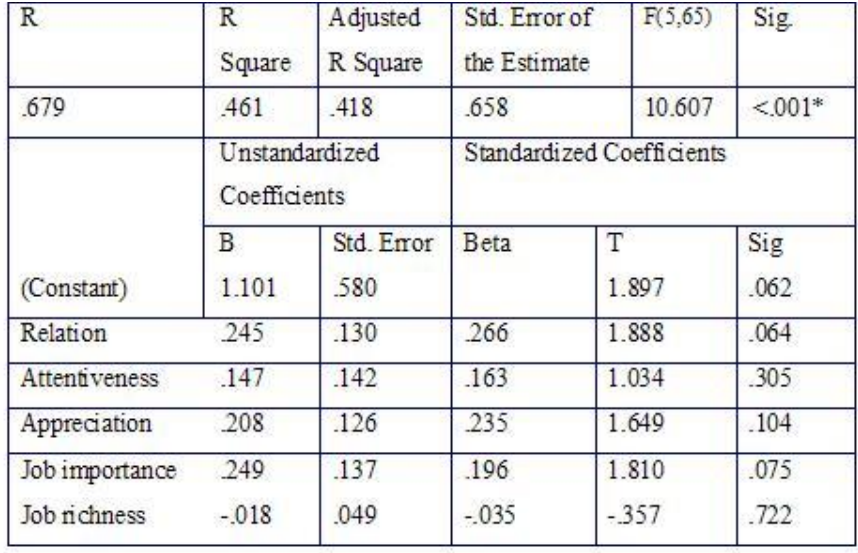
Table 3. A Univariate Regression Analysis for variables predicting "Job